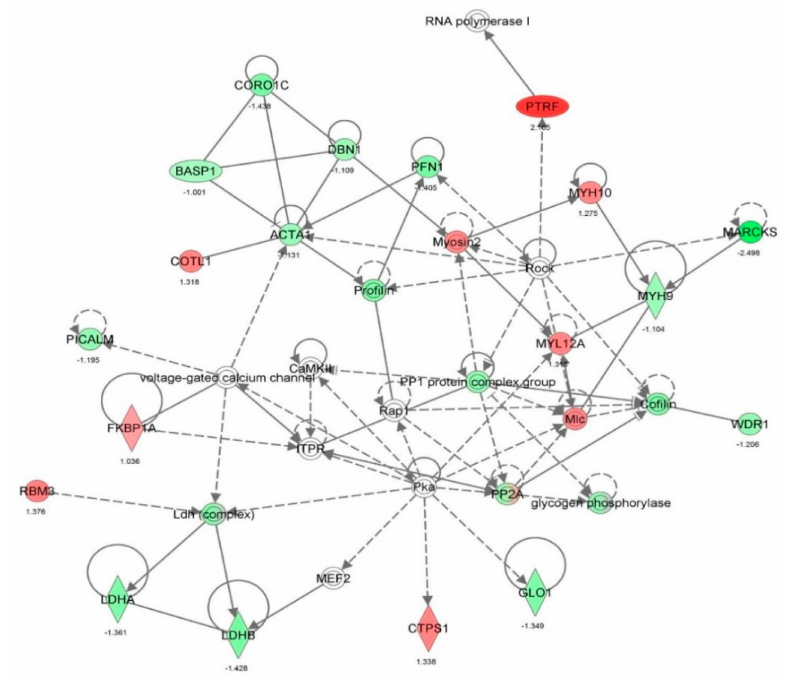
Figure 19. Vancomycin regulated cellular movement, connective tissue disorders, and hematological disease. Red indicates an up-regulation; green indicates a down-regulation. The intensity of green and redcolors indicates the degree of down- or up-regulation. Solid arrow indicates direct interaction and dashed arrow indicates indirect